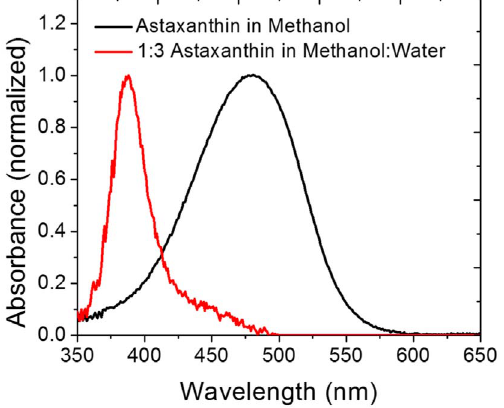
Figure 4. Normalized absorbance spectra of astaxanthin and astaxanthin H-aggregates. The UV-Vis spectra of astaxanthin dissolved in methanol and astaxanthin dissolved in methanol in the presence of distilled water in a ratio of 1:3 was recorded. The absorbance peak of astaxanthin dissolved in methanol and mixed with water resulted in a blue spectral shift which is indicative of the formation of H-aggregates [14,35]. doi:10.1371/journal.pone.0107804.g004 PLOS ONE |